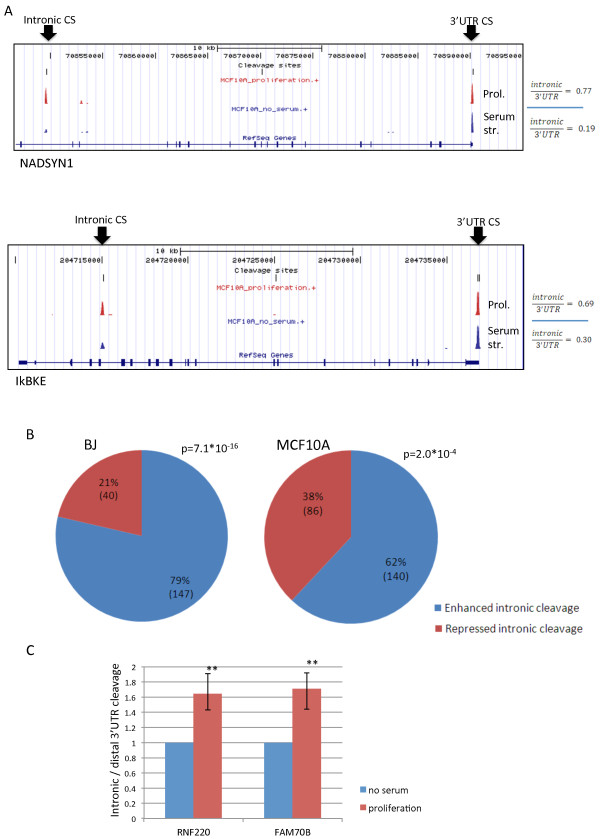
Enhanced cleavage at intronic poly(A) sites in proliferation. (a) Two examples of genes that showed significant enhancement of cleavage at intronic poly(A) sites in proliferative MCF10A cells compared to serum-starved ones. Ratios between intronic and 3' UTR peak levels are indicated to the right. (b) Global enhancement of cleavage at intronic sites was associated with proliferation in both BJ cells (left, proliferative compared to confluent cells) and MCF10A cells (right, proliferative compared to serum starved cells). (c) Enhanced cleavage at intronic sites in proliferation was validated using 3'-end qRT-PCR applied to intronic and 3' UTR distal poly(A) sites of RNF220 and FAM70B, measured in MCF10A under proliferative and serum-starved conditions. The figure shows means (± standard deviation) of three independent experiments (for both genes, **P < 0.005; one-tailed t-test).